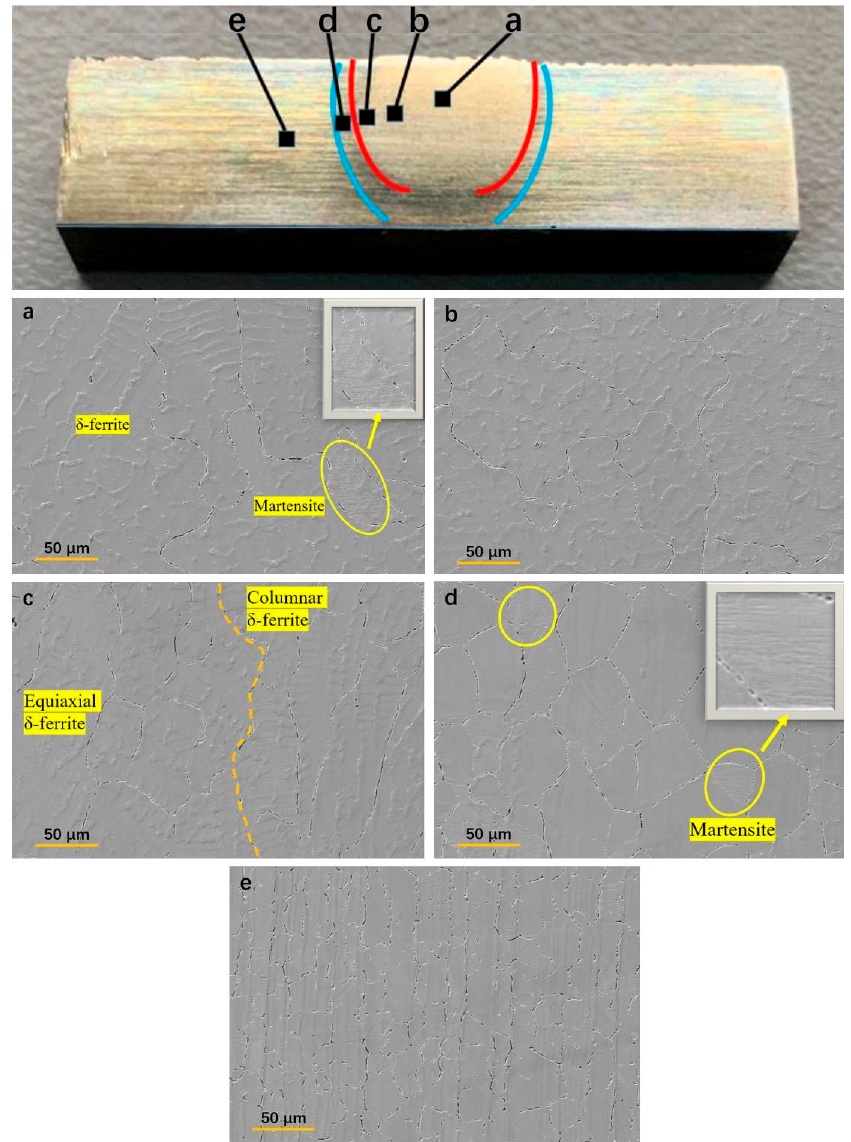
Figure 8. SEM microstructure of the fusion zone, HAZ and base material of nanoscale Fe 2 O 3 flux weldments: ( a ) fusion zone 1; ( b ) fusion zone 2; ( c ) fusion zone 3; ( d ) heat-affected zone (HAZ); ( e ) base